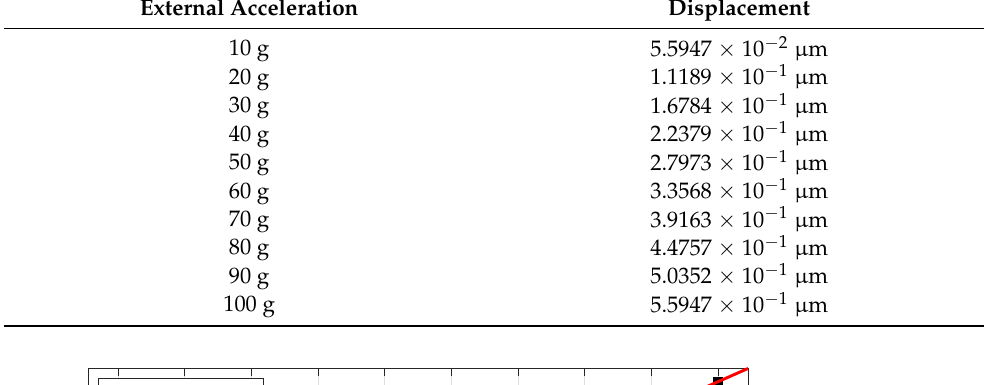
Table 2. Displacements of the micro-accelerometer under different accelerations along the x-axis.